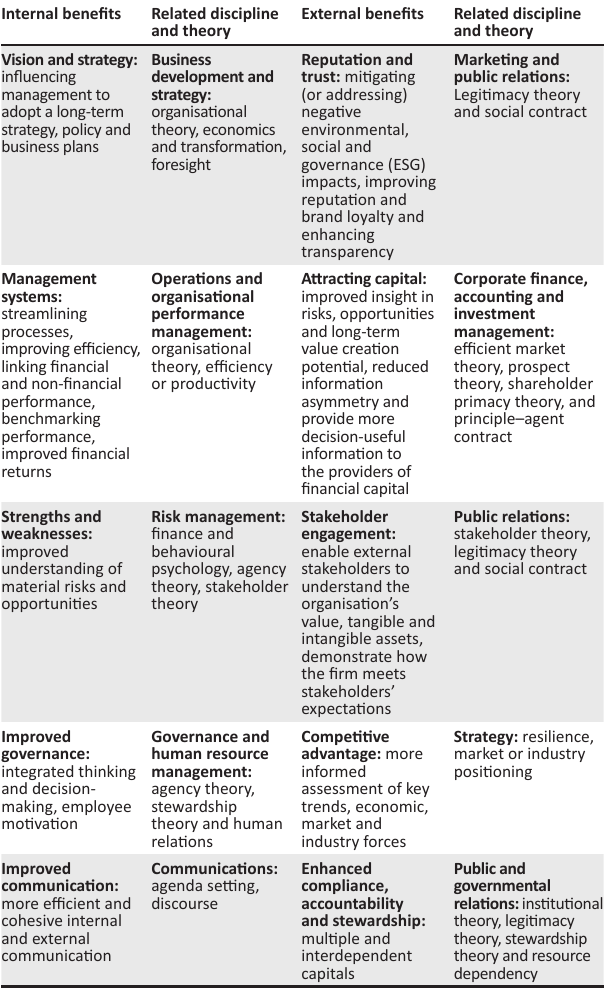
TABLE 1: Motivations for corporate reporting and related